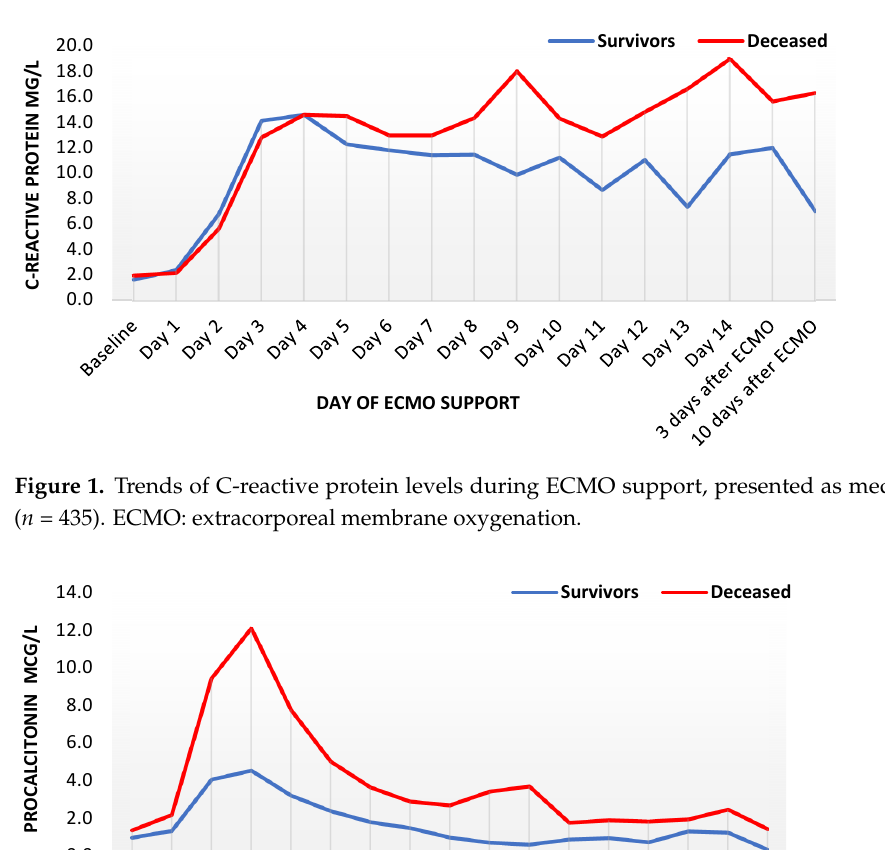
Figure 4. Trends of platelet count during ECMO support, presented as median values ( n = 435). ECMO: extracorporeal membrane oxygenation. Antithrombin showed a similar course with a distinct decrease until the third day and a slow recovery thereafter, being faster in survivors (Supplementary Figure S2). All patients demonstrated similar median values of hemoglobin (around 9 g/L) over the time course (Supplementary Figure S3). 3.3. Adverse Events during ECMO Support The most frequent adverse event was hemorrhage (199/435, 46%), followed by thrombosis (110/435, 25%) and sepsis (80/435, 18%) (Table 2). Overall, in ‐ hospital mor ‐ tality was 38% (167/435) with the main causes of death being cardiac failure (68/435, 42%) and multiple ‐ organ dysfunction syndrome (51/435, 31%) (Table 2).